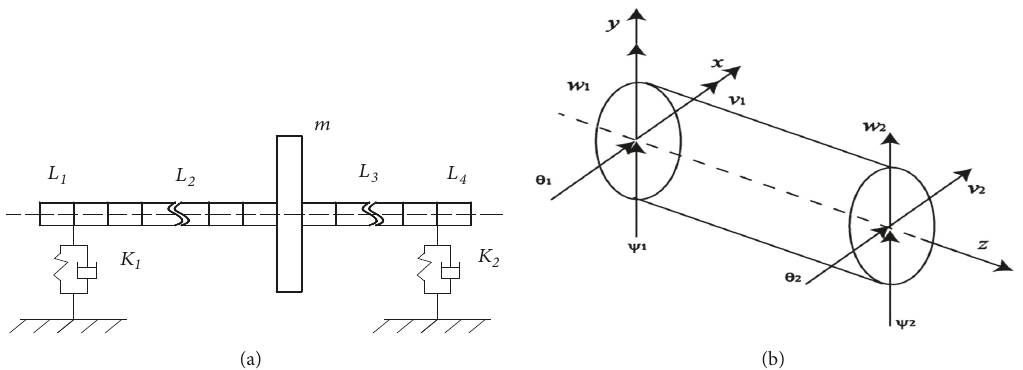
Figure 1: Schematic diagram of the rotor system: (a) rotor model and (b) shaft element coordinates in fixed frame.